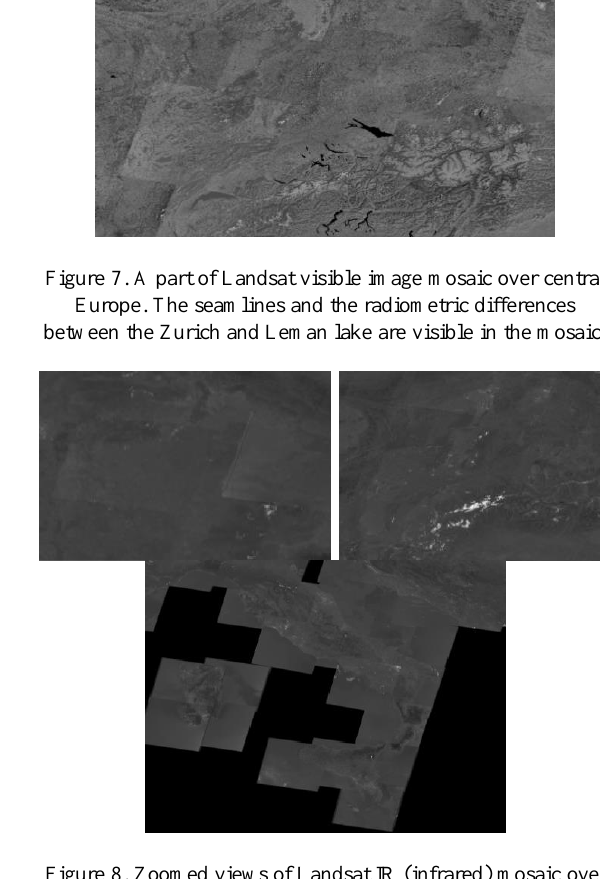
Figure 8. Zoomed views of Landsat IR (infrared) mosaic over different parts of